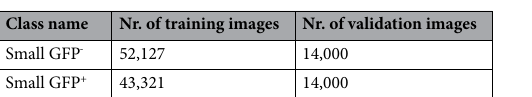
Table 2. Number of images in training and validation